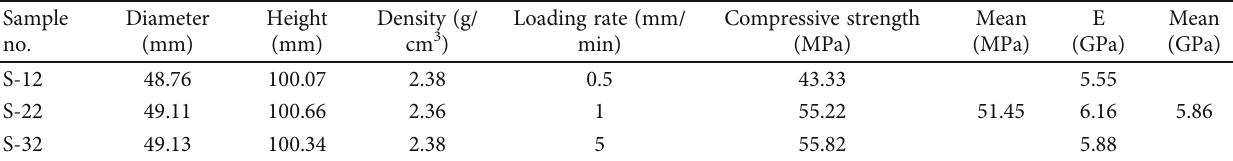
Figure 2: Characteristics of mine pressure: (a) working face position and (b) spatial distribution of support resistance. Table 1: Physical and mechanical parameters of sandstone under uniaxial